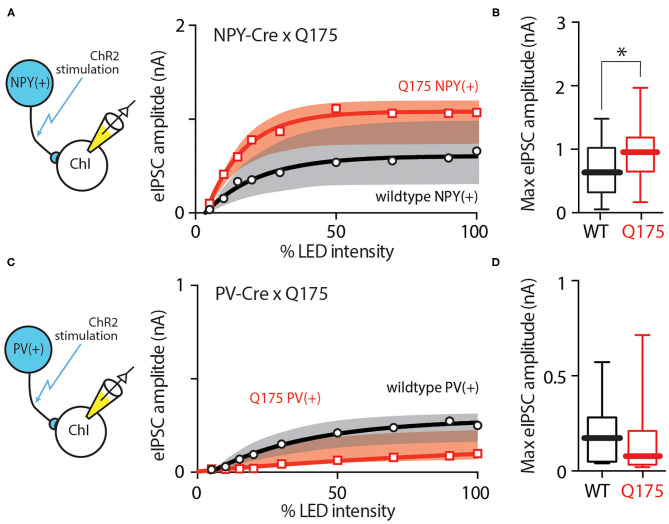
NPY(+) but not PV(+) GABAergic signaling to ChIs was enhanced in zQ175+/− mice. (A) Input - output relationship showing enhanced GABA signaling from NPY-expressing cells in ChIs at progressively higher LED intensities. Data from zQ175+/− mice (red) are plotted next to WT (black) mice. (B) Box and whiskers plot showing increased eIPSC amplitude at maximum stimulation intensity. (C) Input - output relationship and maximum eIPSC amplitude box and whiskers plot showing no difference between WT and zQ175+/− mice at the PV(+) - ChI GABAergic synapse. (D) Box and whiskers plot showing no significant difference in eIPSC amplitude at maximum optical stimulation intensity. *P < 0.05.